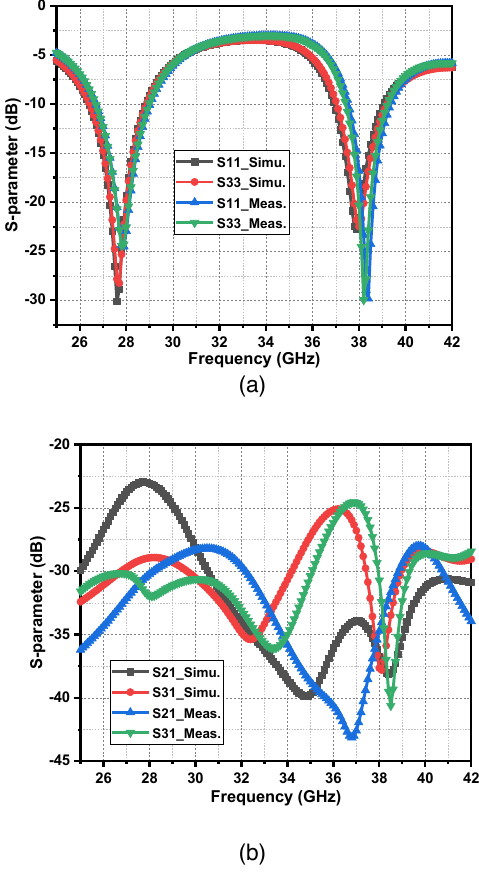
The MIMO antenna (a) reflection and (b) transmission